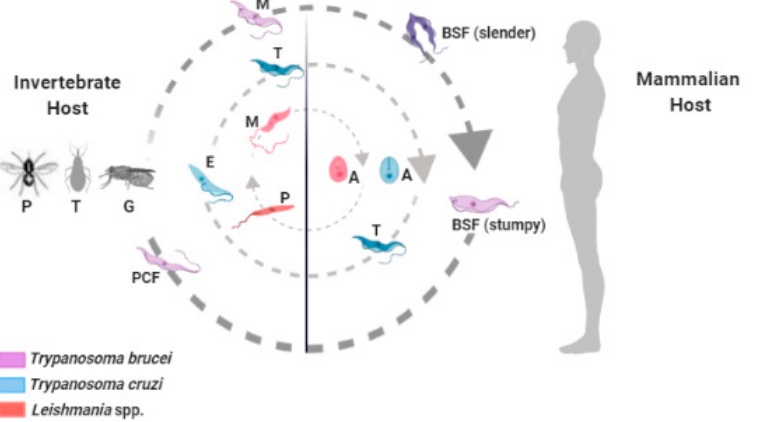
Figure 1. Schematic representation of the biological cycle of some trypanosomatids: Trypanosoma brucei (lilac), Trypanosoma cruzi (blue), and Leishmania spp. (red). Invertebrate hosts: Phebotomineos (P), Triatoma sp. (T), and Glossina sp. (G). The different evolutionary forms of these protozoa are represented: bloodstream form (BSF); procyclic form (PCF); metacyclic forms (M); amastigotes (A); promastigotes (P); epimastigotes (E); and trypomastigotes (T).